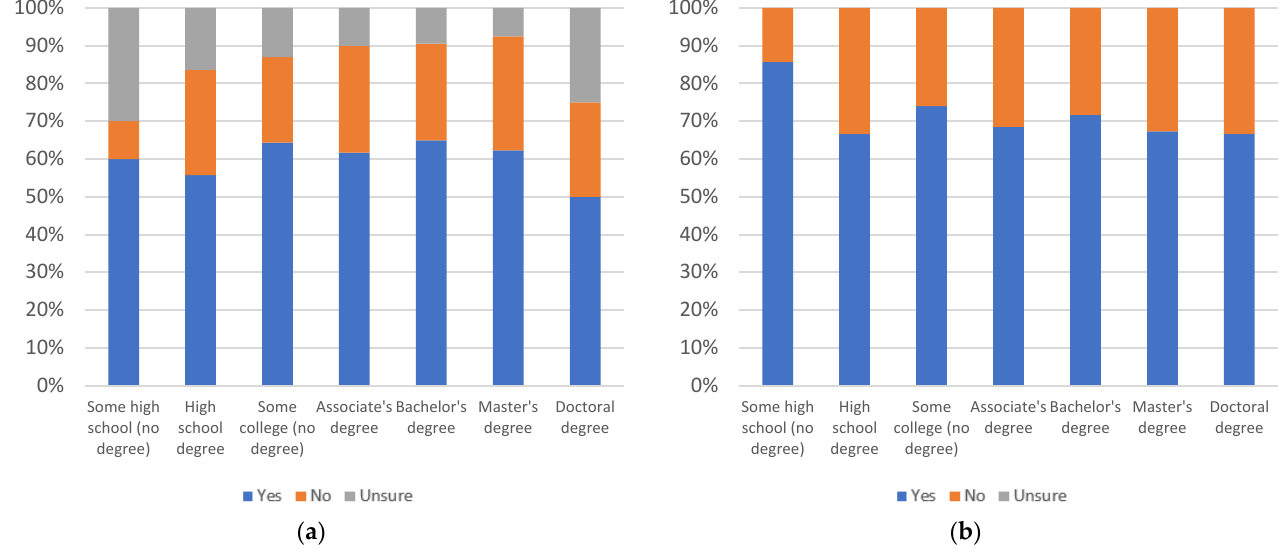
Figure 76. Label use, by education level: ( a ) with uncertain respondents (left) and ( b ) without un- certain respondents (right).